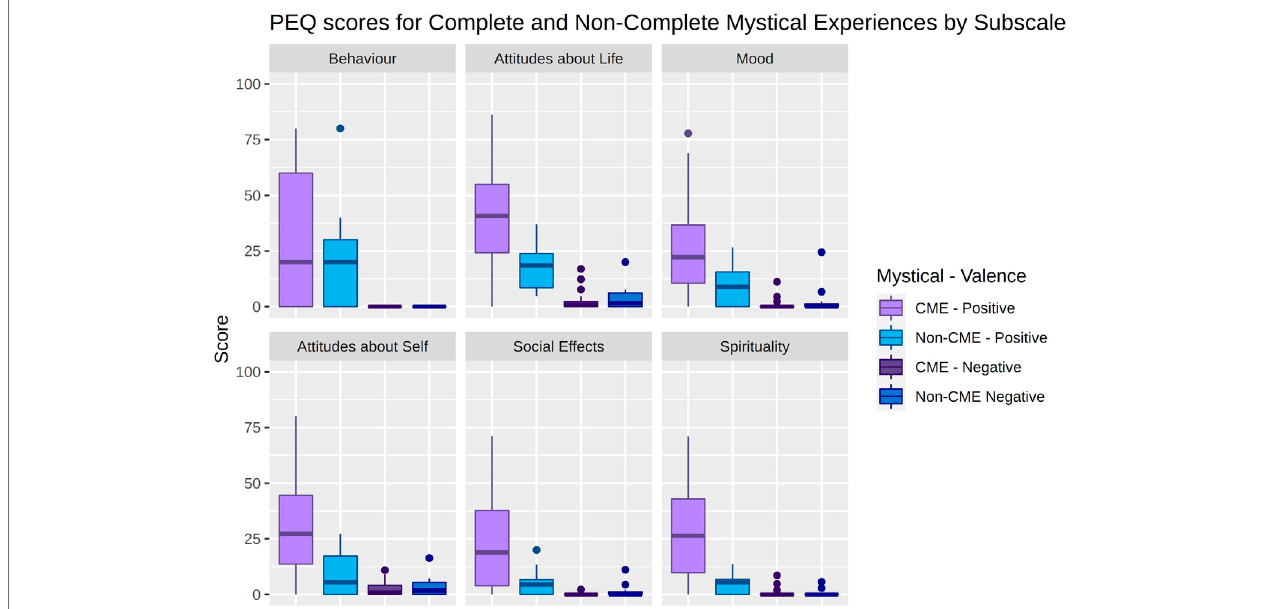
FIGURE 2 | Boxplots showing Persisting Effect Questionnaire (PEQ) scores relating to either Complete Mystical Experiences (CME) (Purple) or non-CME (Blue). Each plot represents the positive (lighter colours, left) and negative (darker colours, right) aspects of each PEQ subscale. The middle line in each box represents the median. Lower and upper hinges represent fi rst and third quartiles. Datapoints more than 1.5 interquartile range beyond the hinges are plotted as outliers.